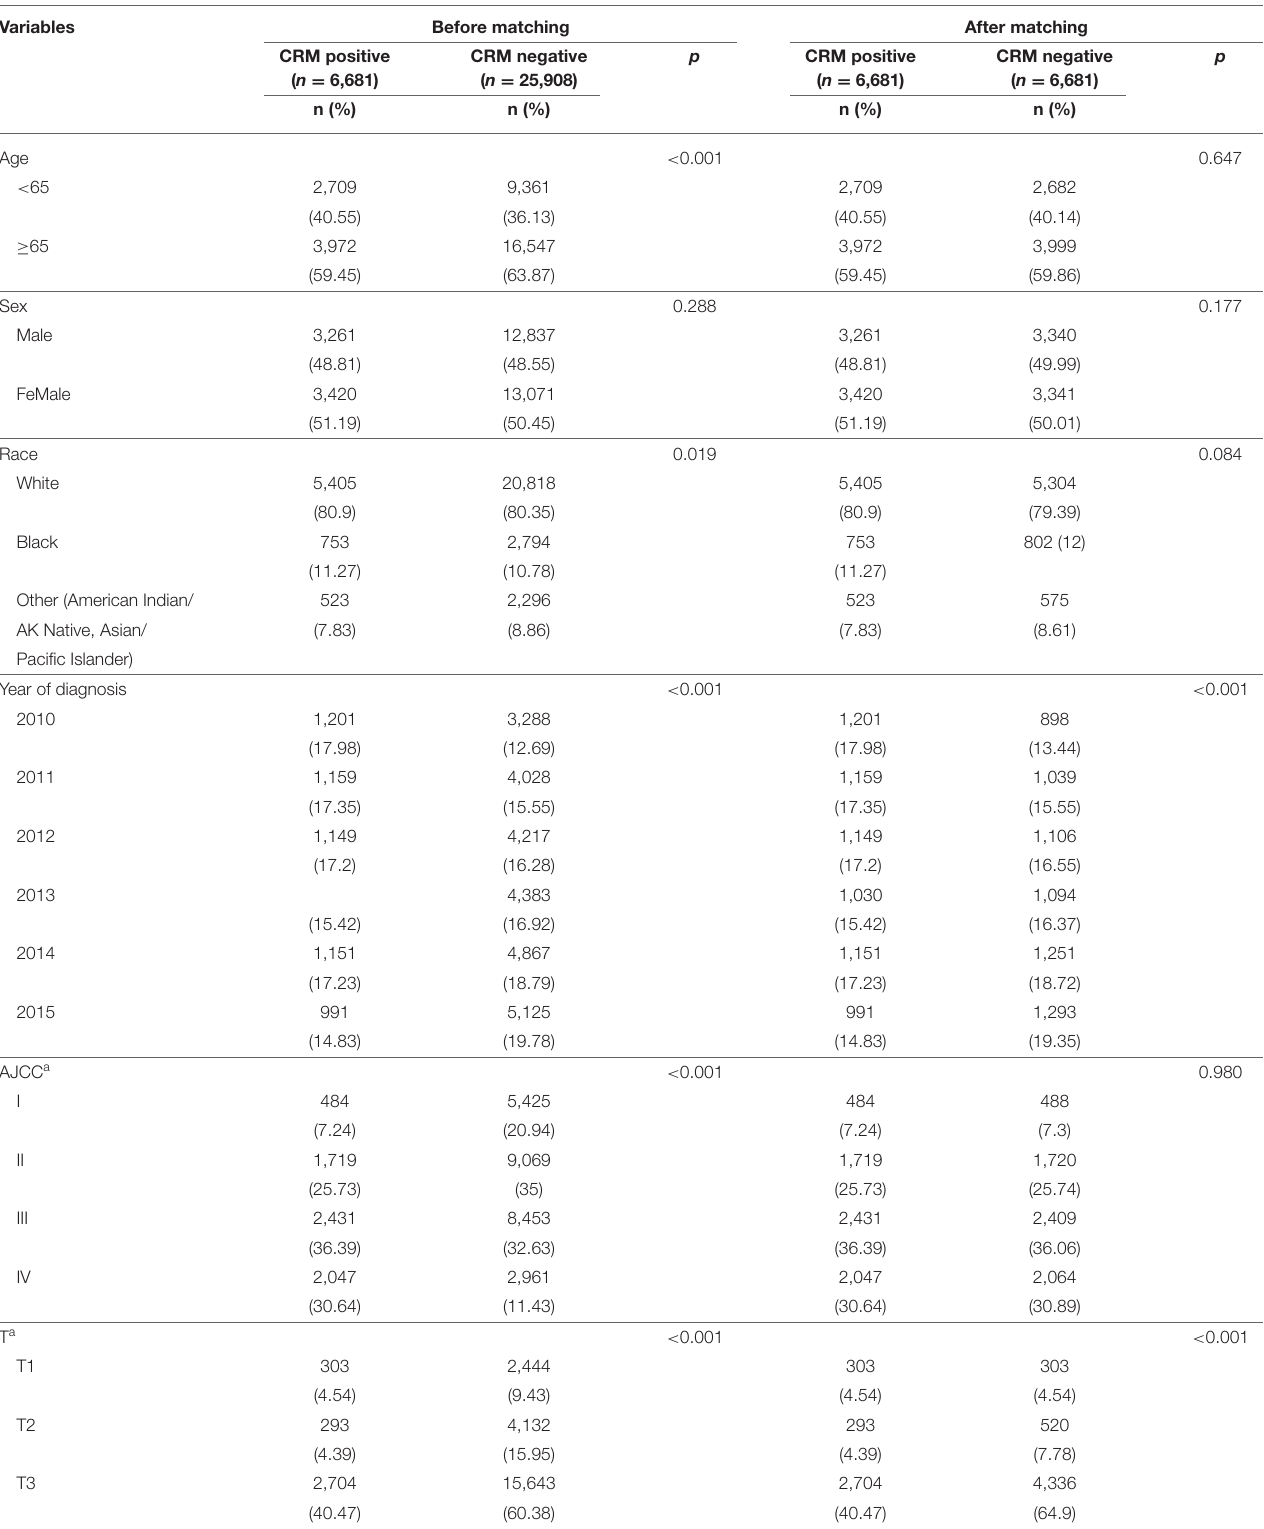
TABLE 1 | Baseline characteristics for CRM-positive and CRM-negative patients prior to and after propensity score matching.